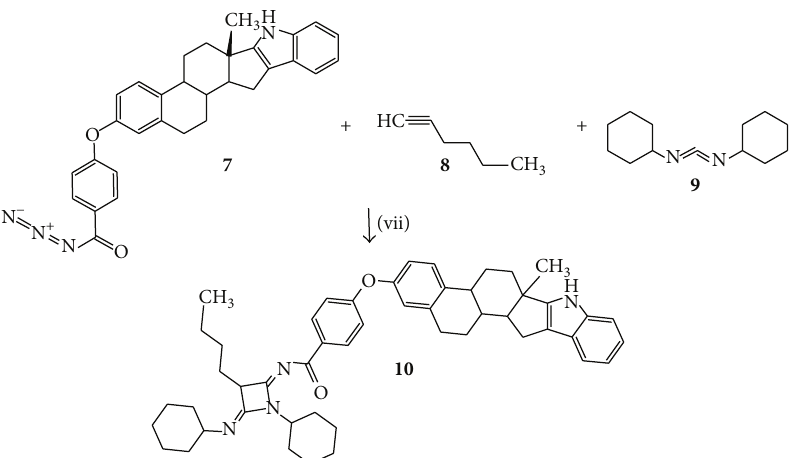
Figure 5: Synthesis of 3-[4-(2-butyl-3-cyclohexylimino-4-piperidin-1-yl-cyclobutylidencarbamoyl)]-phenoxy-NH-indolo[2 󸀠 ,3 󸀠 :17,16]estra- 1,3,5(10)triene ( 10 ). Reaction of 7 with 1-hexyne ( 8 ) and 𝑁 , 𝑁 󸀠 -Dicyclohexylcarbodiimide ( 9 ) to form 10 . (vii) = cupric chloride/rt.